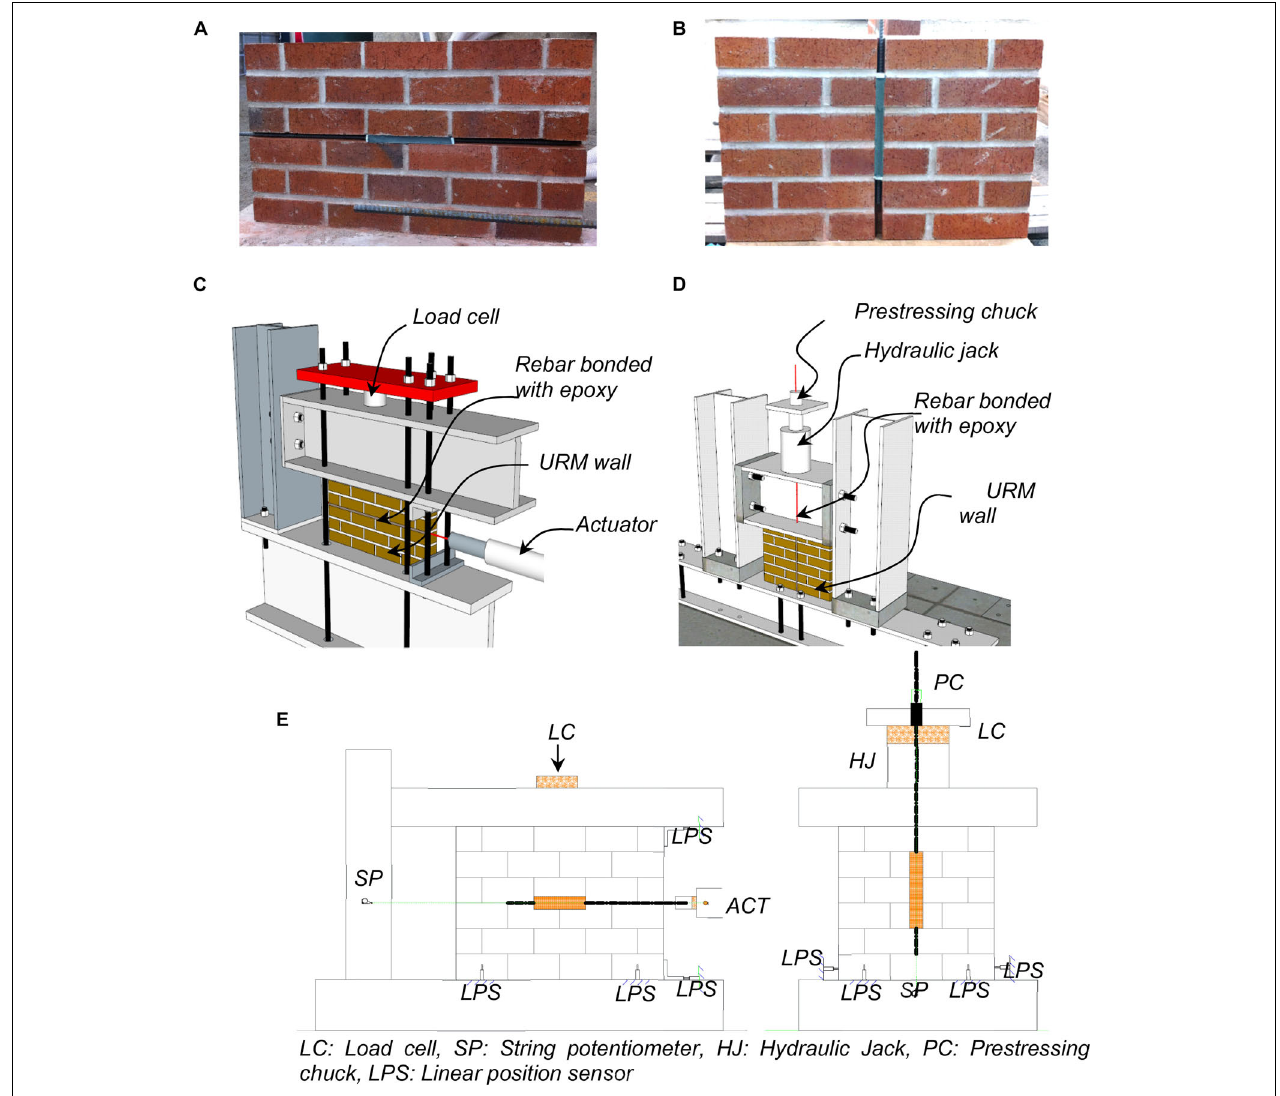
FIGURE 7 | Pull-out tests: (A) horizontal bar pull-out test specimen, (B) vertical bar-pull-out test specimen, (C) horizontal bar pull-out test setup, (D) vertical bar pull-out test setup, and (E) sensor layout for horizontal and vertical NSM reinforcing steel